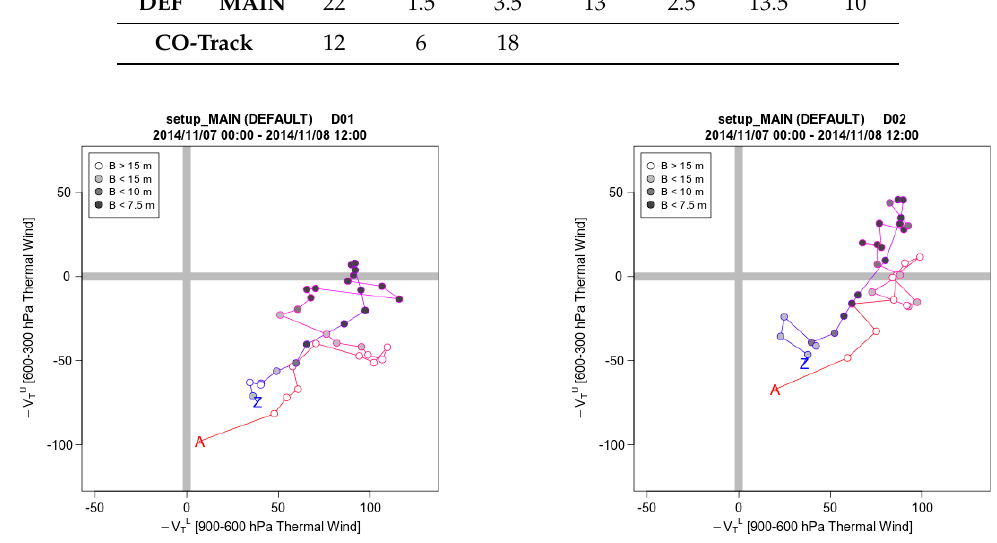
Figure 8. Phase space diagrams of − V TL (900–600 hPa) against − V TU (600–300 hPa) as predicted from model PBL/LSM experiments in D01 for: ( a ) setup_1, ( c ) setup_2, ( e ) setup_3, ( g ) setup_4, ( i ) setup_14 and in D02 for: ( b ) setup_1, ( d ) setup_2, ( f ) setup_3, ( h ) setup_4, ( j ) setup_14. Symmetry B is denoted by the shade of circles.